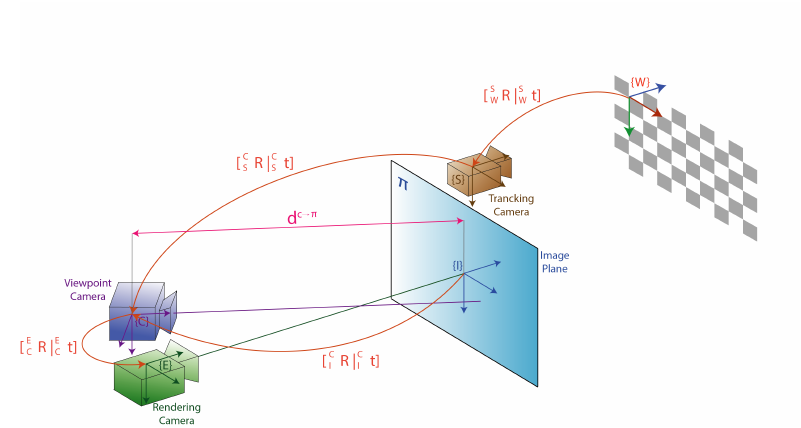
Figure 2. Illustration of the setup for the off-line calibration of the see-through